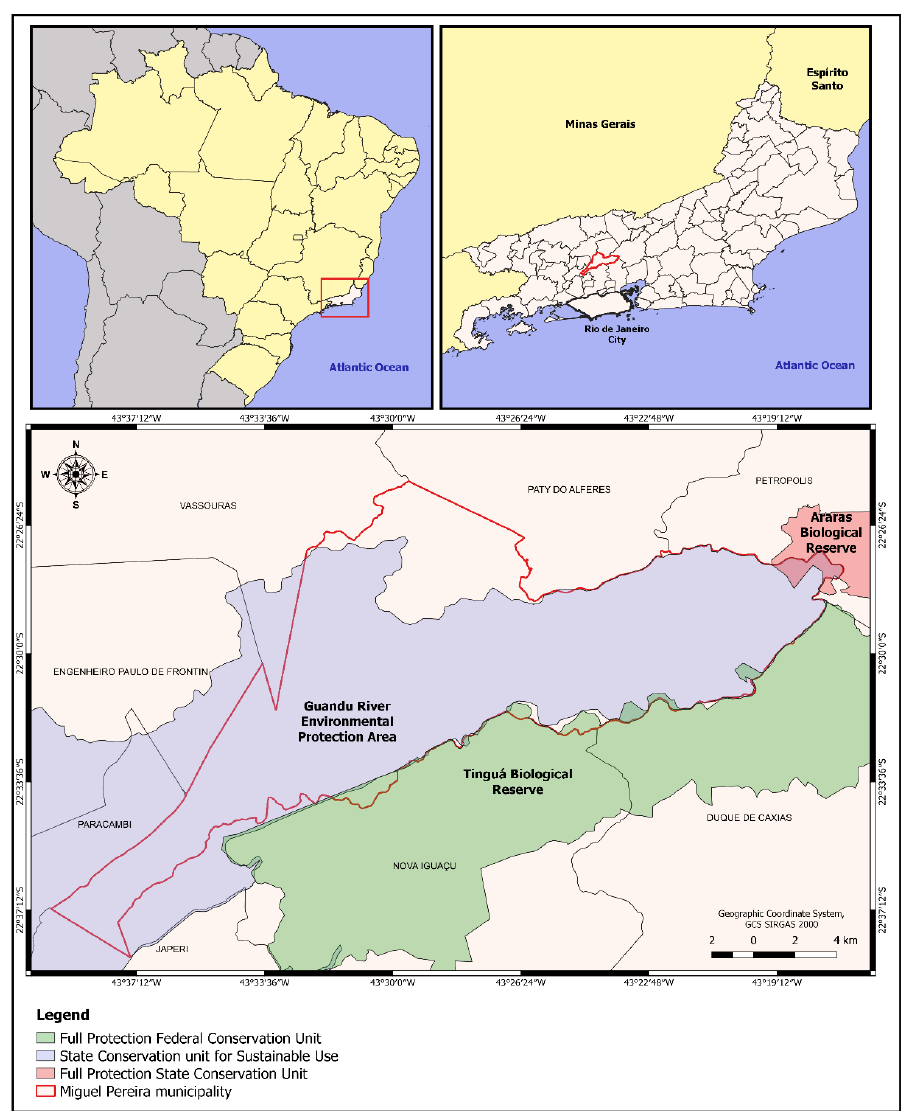
Figure 1. Location of Miguel Pereira municipality in the State of Rio de Janeiro (Brazil), overlaying the Guandu River Environmental Protection Area and the Tinguá and Araras Biological Reserves.